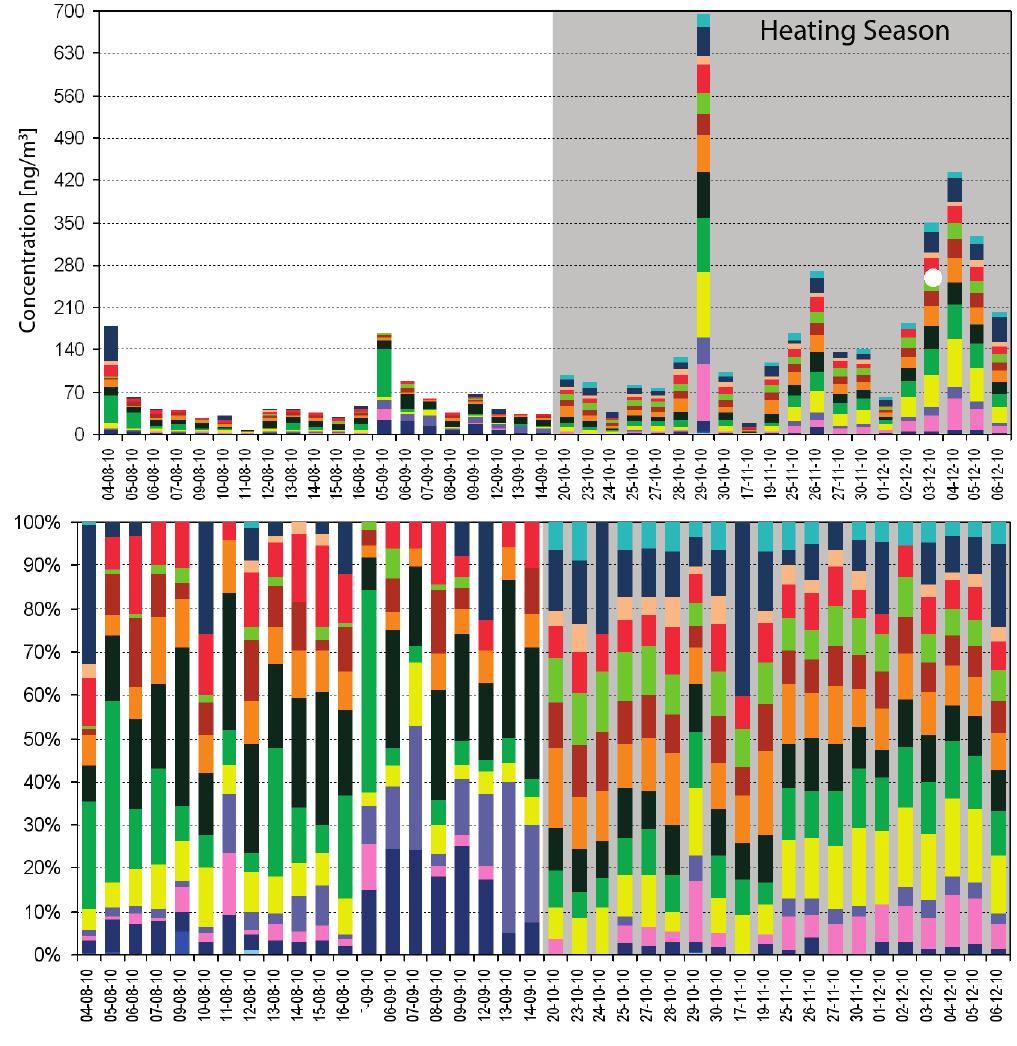
Figure 4. Twenty-four-hour concentrations of 16 PAHs contained in PM 1 and percentages of specific PAHs in the PAH sum at the traffic point